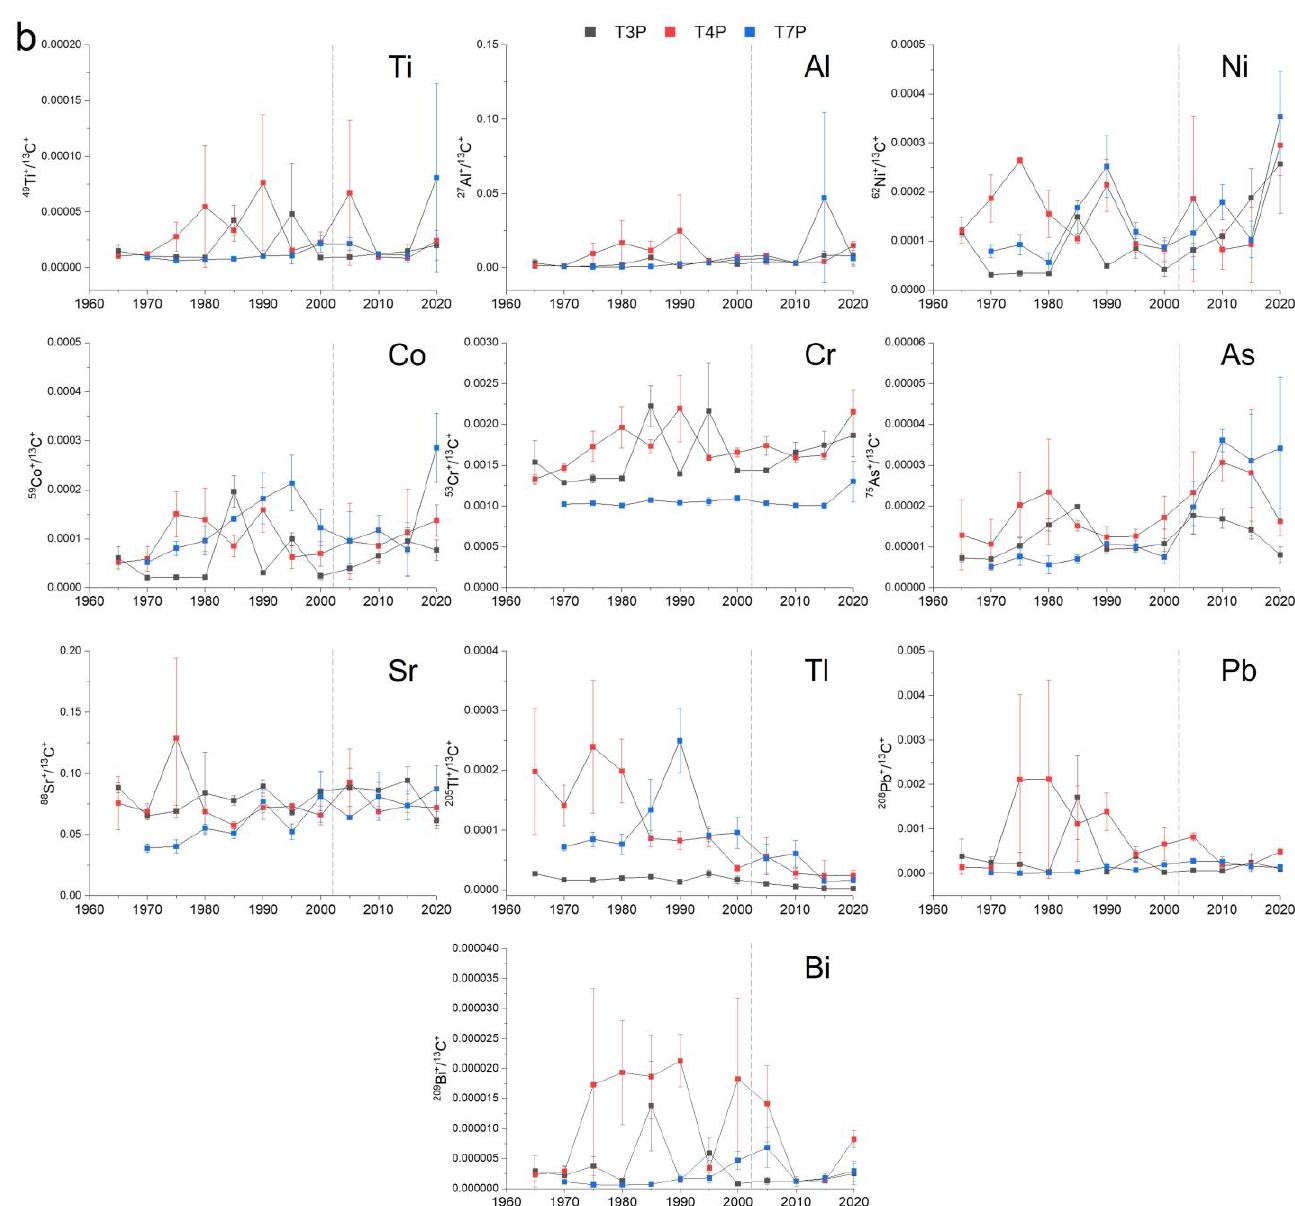
Figure 2. Elemental signal in Harbin recorded in the tree rings of three tree cores (T3P, T4P, T7P trees) from 1965 to 2020. The heartwood – sapwood boundary is delineated by a dashed line. Groups: ( a ) essential (macro- and micro-) nutrients, ( b ) trace metals. Data show the means ± standard deviation (n = 3).